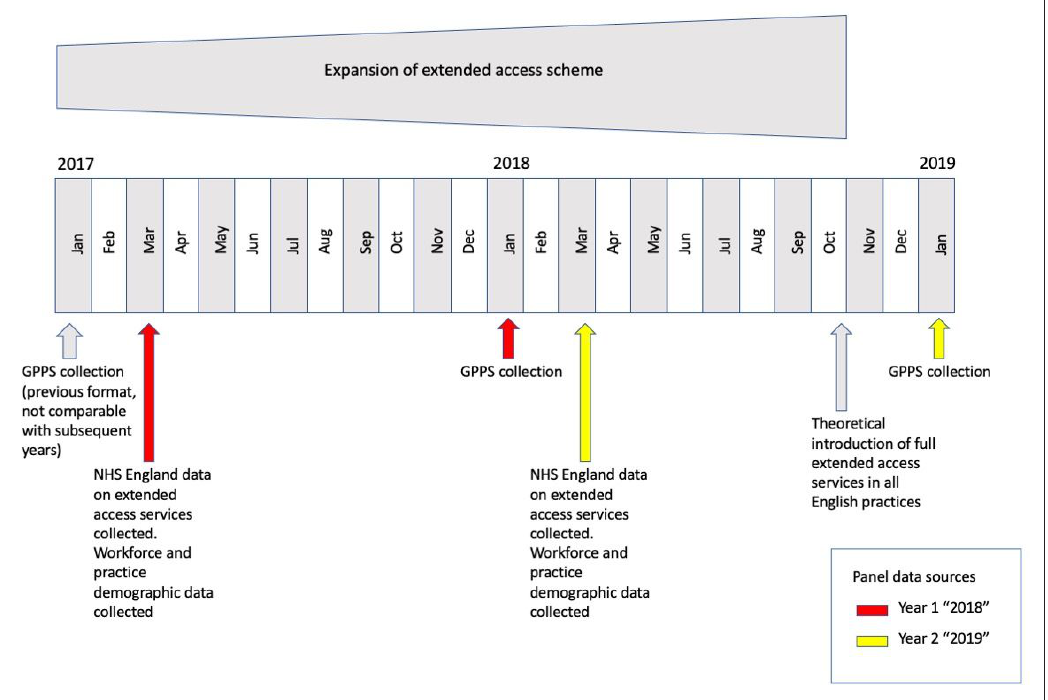
Figure 1 Timeline showing data collection points. GPPS = GP Patient Figure 1 – Timeline showing data collection points